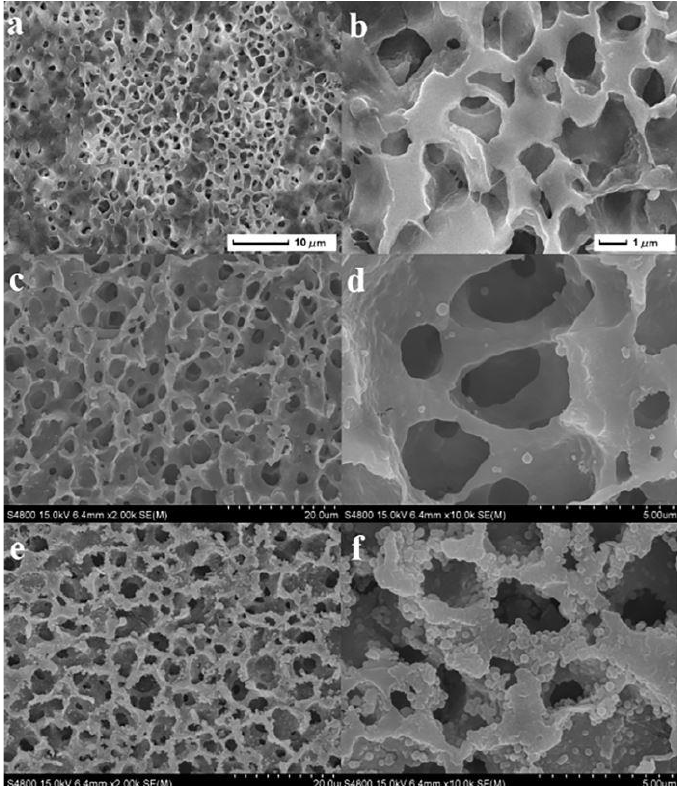
Figure 13. SEM images of ( a , b ) a simple PVDF membrane, ( c , d ) a PVDF membrane with pDA coating, and ( e , f ) the final membrane with SiO 2 nanoparticles added to the final membrane surface. Reprinted from Separation and Purification Technology, Volume 209, Jiuyun Cui, Zhiping Zhou, Atian